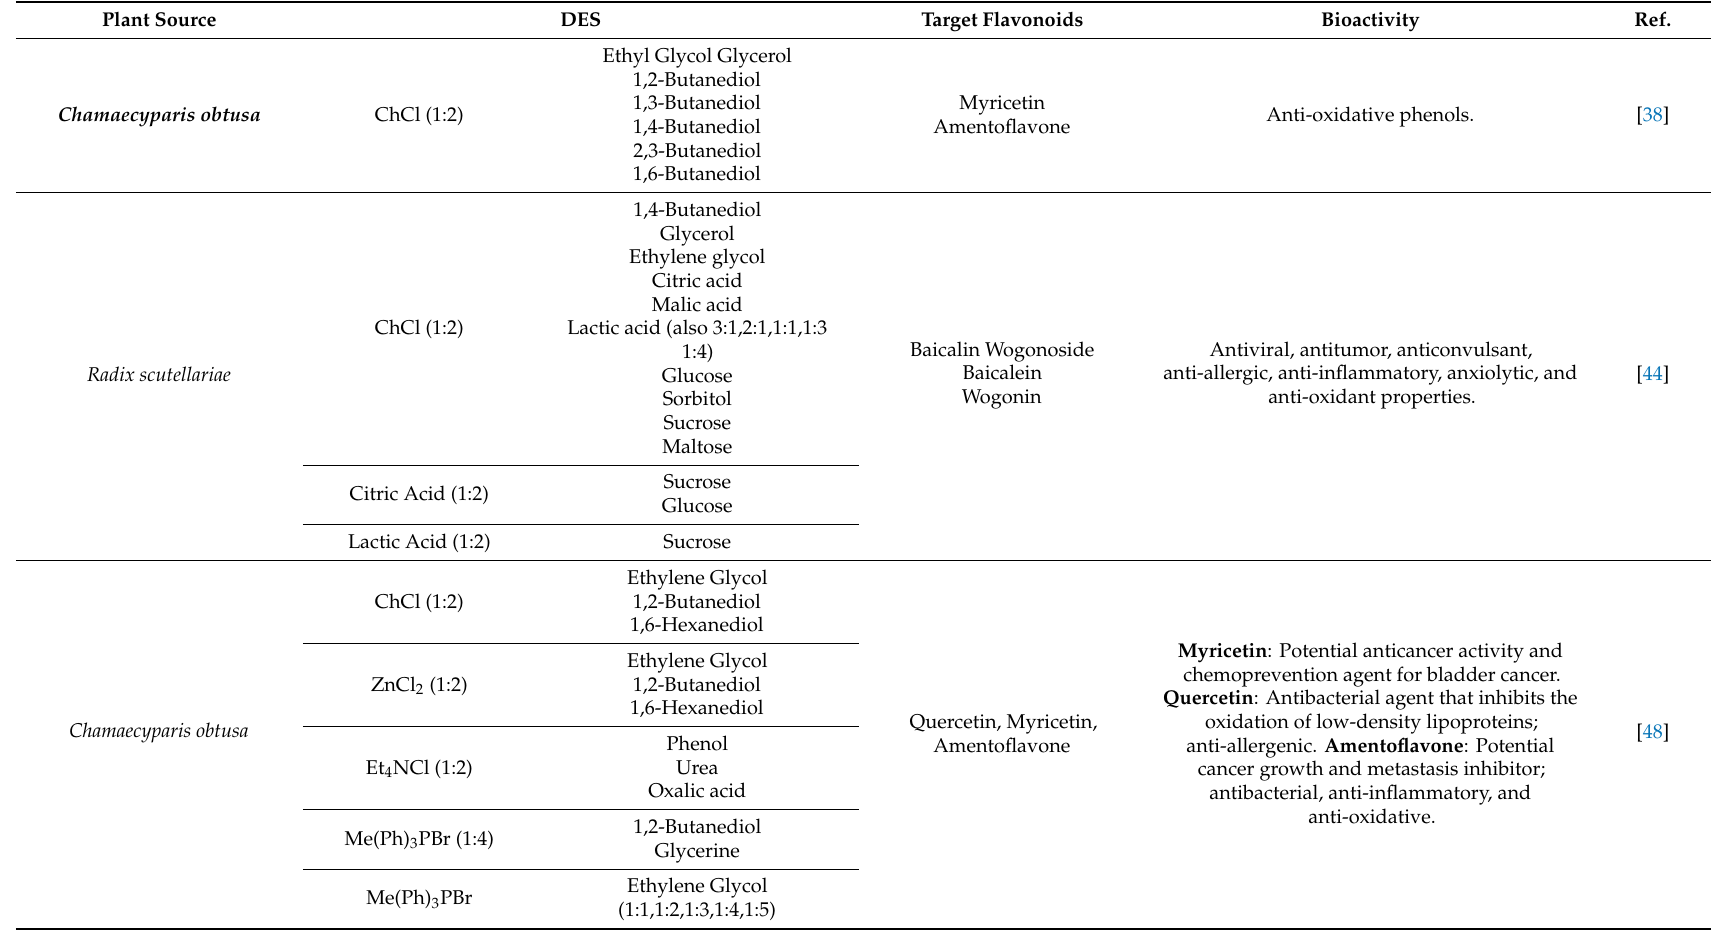
Table 2. Overview of extraction examples from the literature, presenting the plant source, DES employed, target compound, and the bioactive role the writers mention (literature presented in chronological